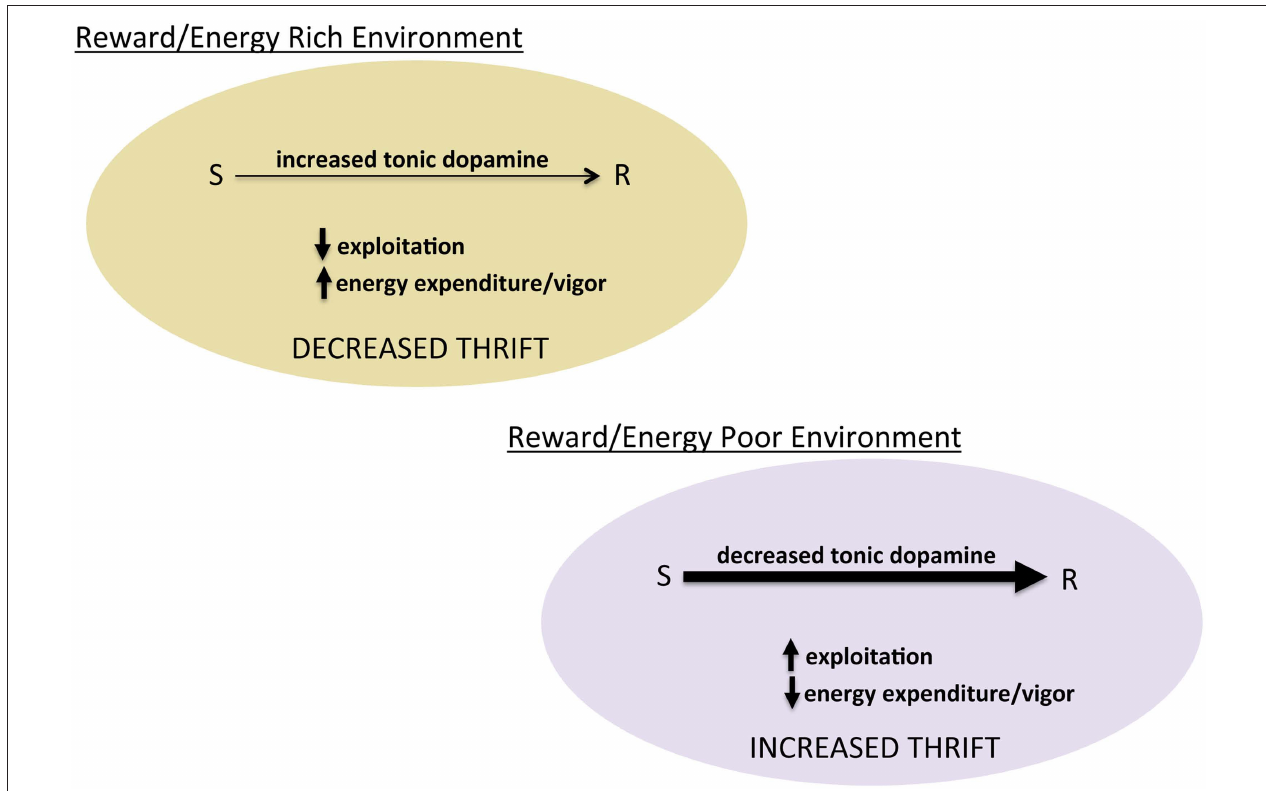
Figure 3 | Tonic dopamine and the balance between exploration and exploitation. Schematic of hypothesized role of tonic dopamine in mediating thrift in energy expenditure and reward pursuit through regulating the degree to which prior reward learning and value biases behavioral